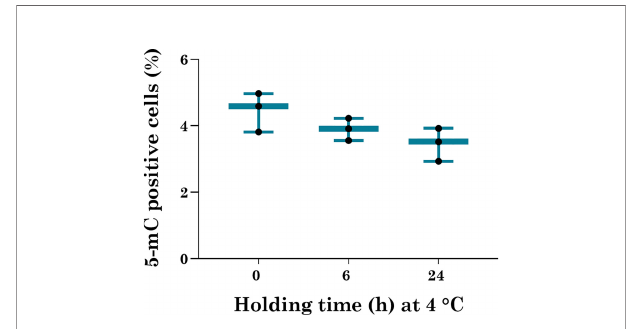
FIGURE 3 | Global DNA methylation analysis in cultured ITT. Levels of percent methylated cytosine (5-mC) in cultured ITT. Cultured ITT held at 0 h intervals were used as a control in comparison to cultured ITT held for 6 and 24 h at 4°C. The data is presented in mean ± SEM (n